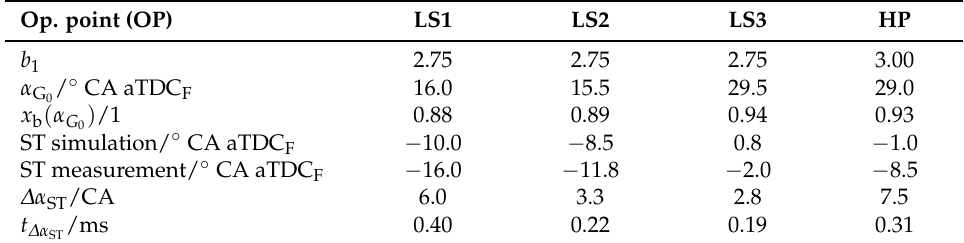
Table 3. Calibrated b 1 values, G -equation deactivation angle α G , and fuel burnt mass fraction at 0 ) ; spark timing (ST) in simulation versus the one in the experiments for G -equation deactivation x b ( α G 0 all operating points, together with the difference in CA ( ∆α ST ) degree as well as in ms ( t ∆α ST